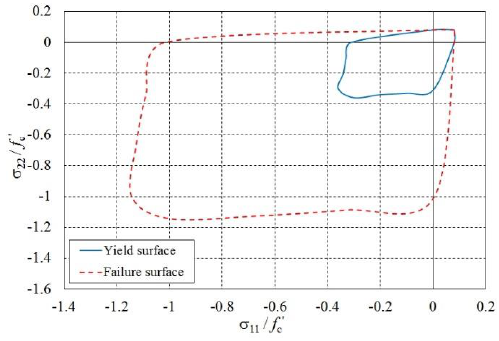
Figure 12. Yield and failure surfaces constructed from local test c.1.